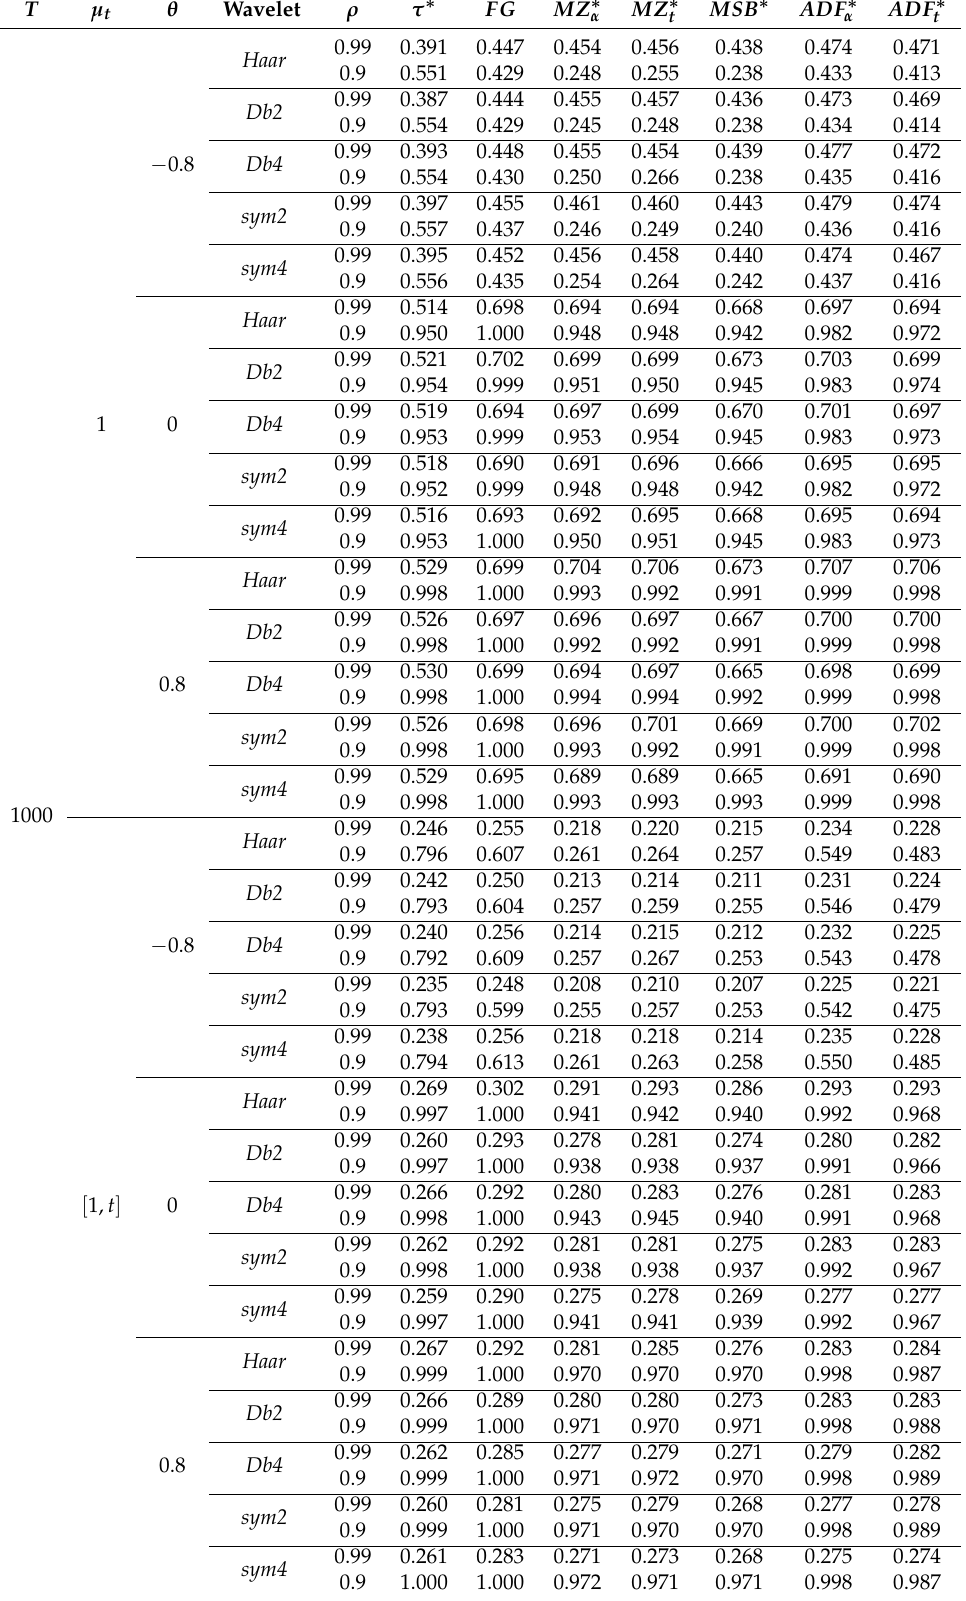
Table 8. The size-adjusted power of wavelet based unit root tests,